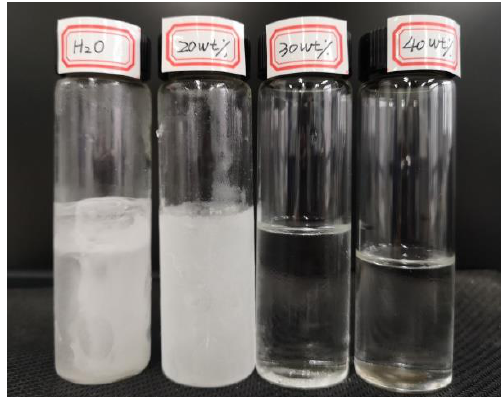
Figure 2. Photographs of KOH at different concentrations after being frozen for 24 h at − 25 ◦ C. Pure water on the left is used for comparison.